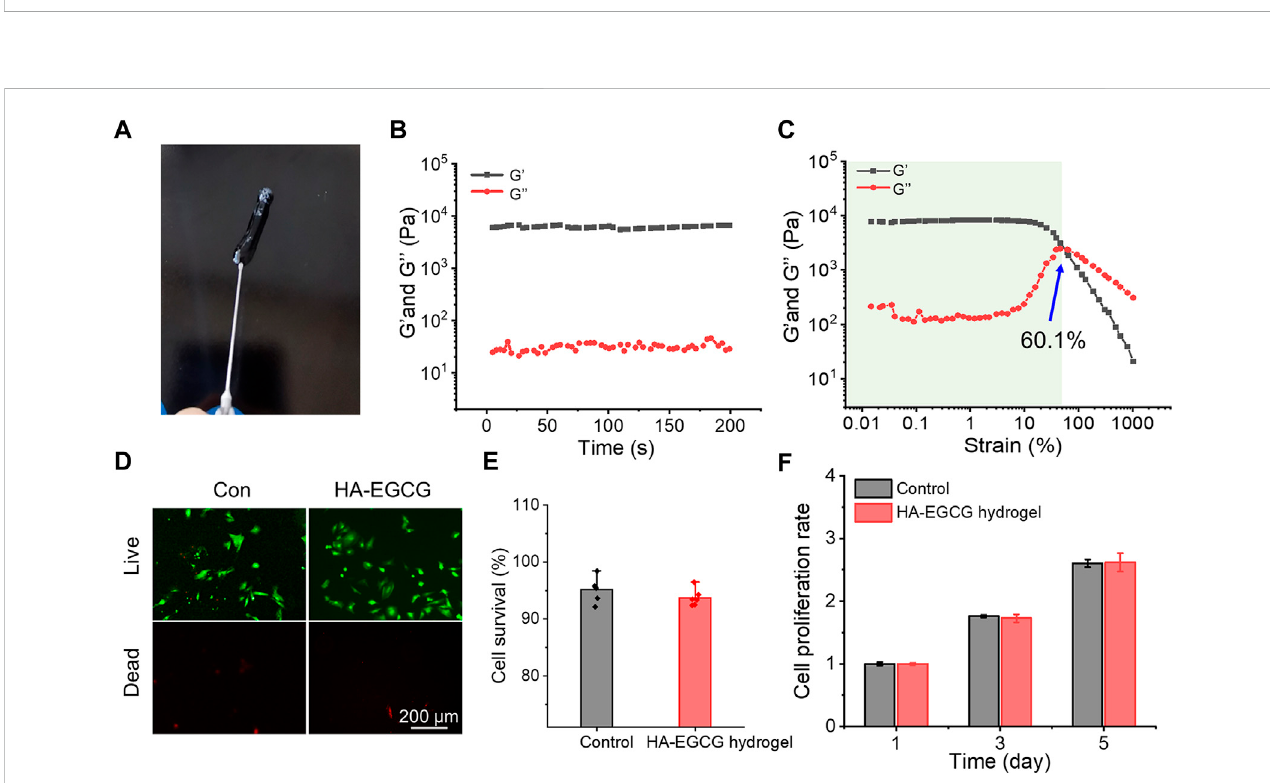
FIGURE 2 Characterization and biocompatibility of HA-EGCG hydrogel. (A) The injectability of HA-EGCG hydrogel extruding by a 26-gauge syringe. (B) Evolution oftheG ′ and G ″ valuesovertime for theHA-EGCG hydrogel. (C) Dependence oftheG ′ andG ″ values overstrain for theHA-EGCGhydrogel. (D) Calcein AM/ PI staining of ADSCs. (E) Quantitative analysis of the survival rates of ADSCs (n = 6). (F) CCK-8 assay of ADSCs to detect cell proliferation (n =